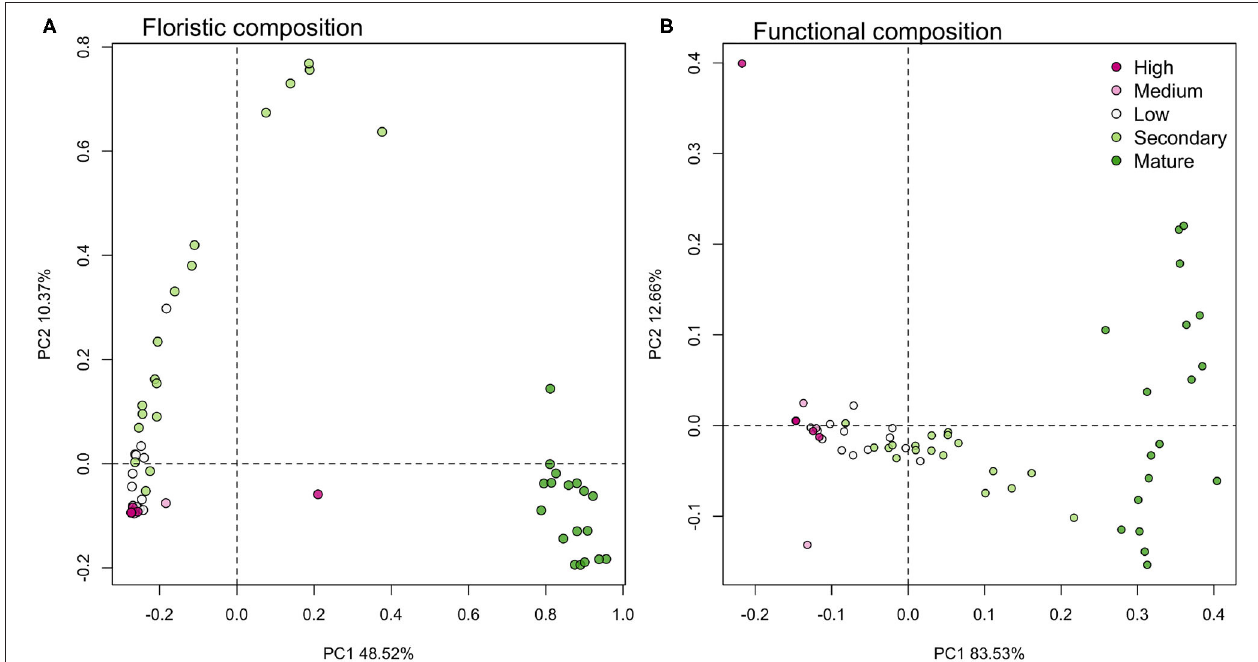
FIGURE 5 | (A) Taxonomic turnover along the fire gradient showed divergent floristic compositions between recovering burned areas and old-growth areas. Along the gradient, burned areas remained strinkingly different from reference old-growth areas (PC1), and their floristic composition diverged orthogonally, along the PC2. (B) Functional composition reflected the structural recovery of the vegetation along the gradient, in spite of the lack of floristic affinity, from High disturbance areas to Secondary Forests along PC1 and toward the functional composition of reference old-growth forests. Variation in the functional composition among mature forests is independent from this recovery and can be seen along PC2 axis. Each point represents a 10 × 10 m subplot in three plots per area ( n =